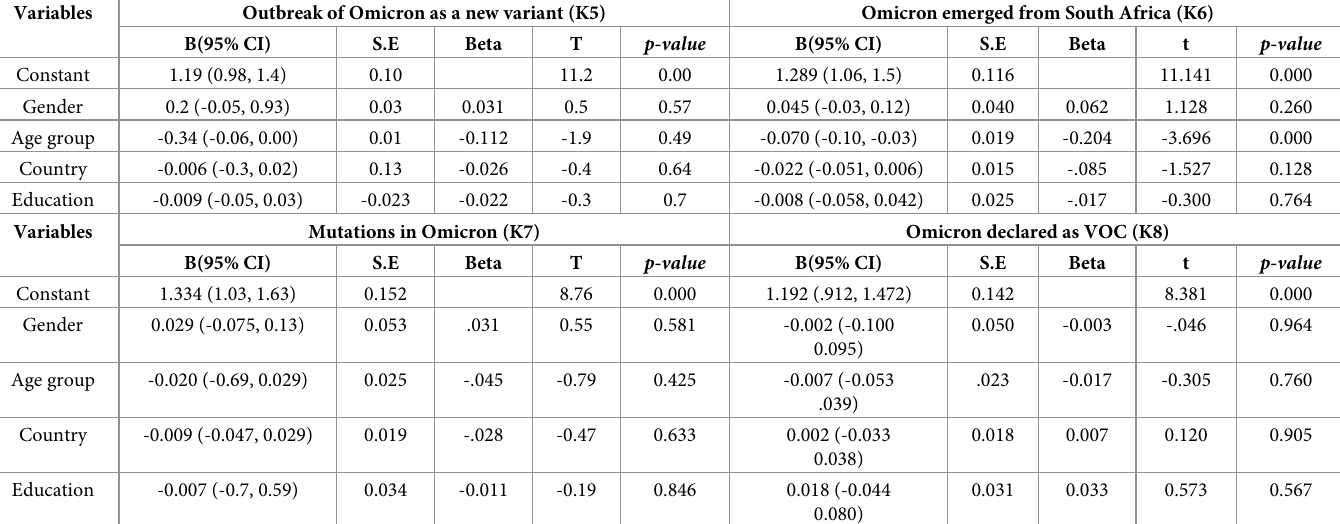
Table 5. Results of Multivariate linear regression analysis for knowledge about B.1.1.529.